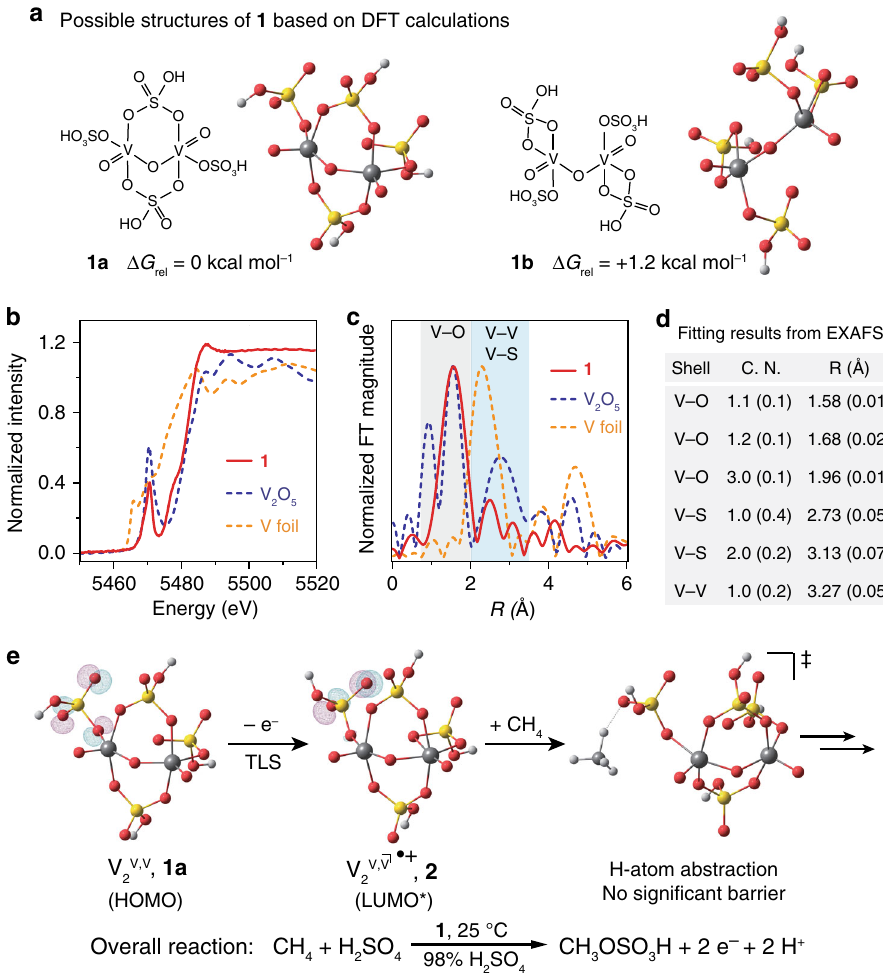
Fig. 4 Structural information of the catalyst and a proposed mechanism. a Possible isomeric structures of 1 and their relative energetics based on DFT calculations. b , c Normalized intensity of V K-edge X-ray absorption near-edge structure (XANES) ( b ) and extended X-ray absorption fi ne structure (EXAFS) ( c ) for 1 (solid red), V 2 O 5 (dashed blue), and metallic V (dashed yellow). d Calculated coordination number (C.N.) and the distance ( R ) away from V atom based on EXAFS results. e Calculated frontier orbitals involved in the TLS and the proposed transition state of C – H activation step. HOMO highest occupied molecular orbital, LUMO lowest unoccupied molecular orbital. *Designated when considering spin – orbital coupling, equivalent to singly occupied molecular orbital (SOMO) in restricted